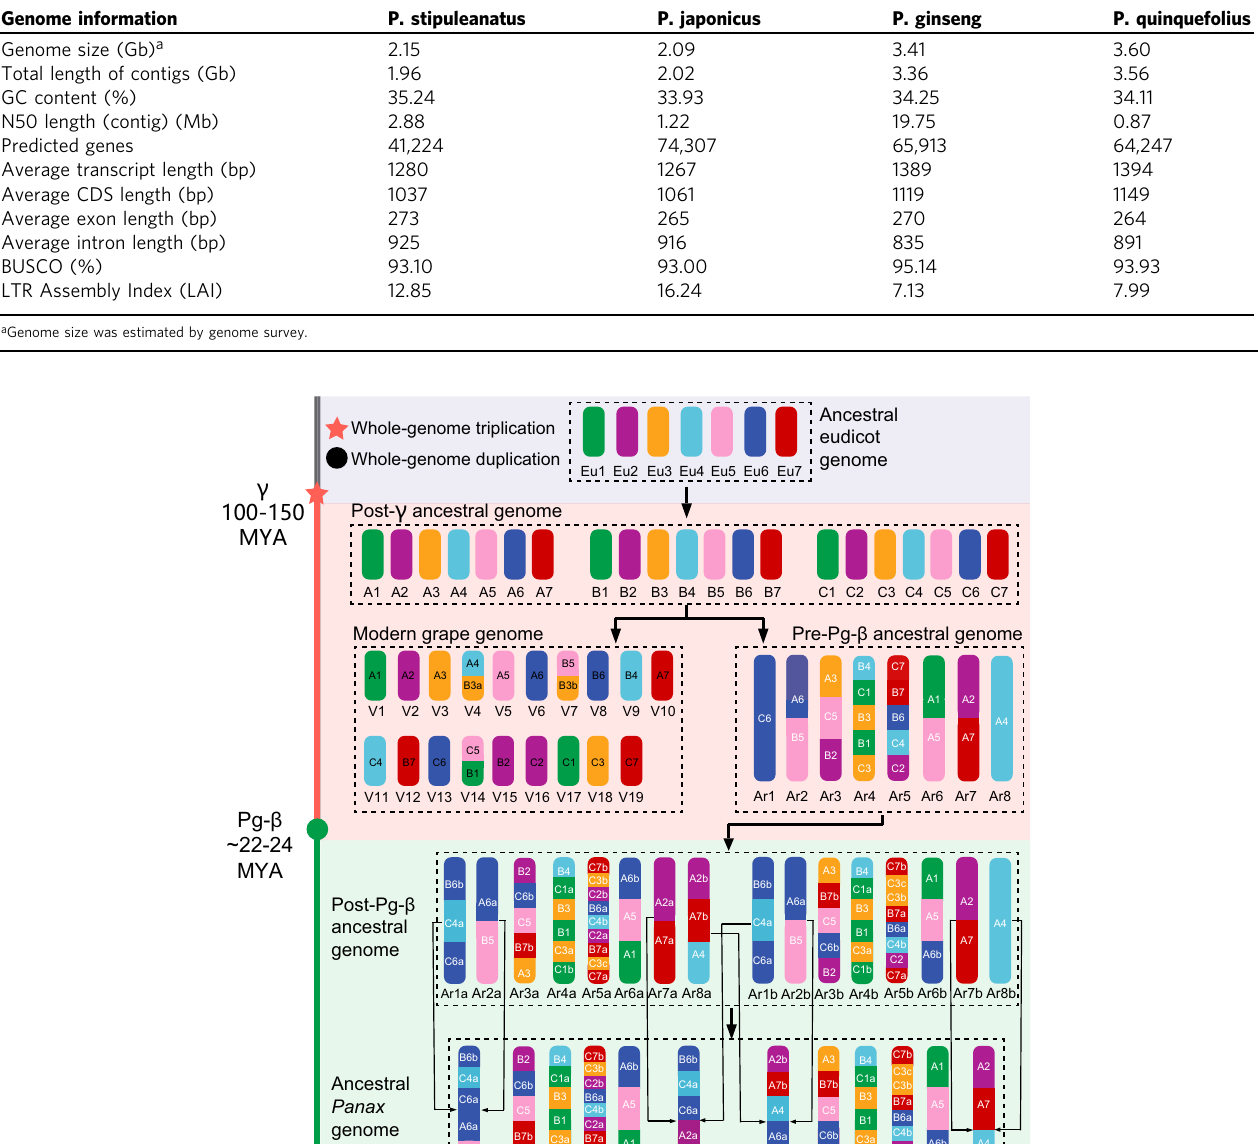
Table 1 Statistics of genome features of the four Panax species. Genome information